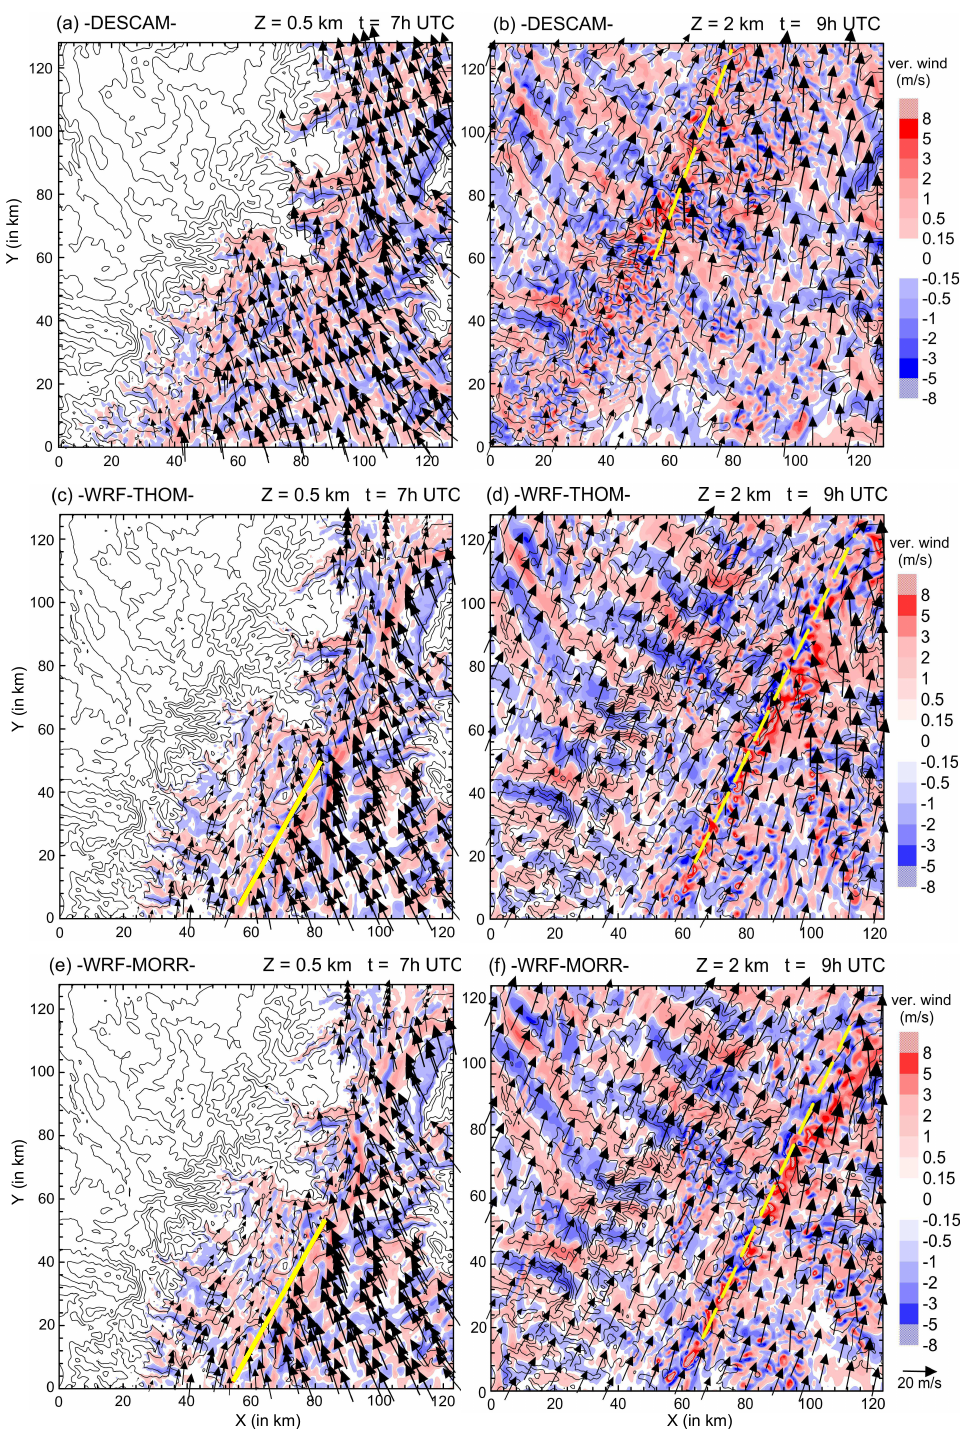
Figure 8. Horizontal and vertical wind components simulated over the innermost domain in DESCAM ( a , b ), WRF-THOM ( c , d ) and WRF-MORR ( e , f ) below the cloud system (at 0.5 km height) ( a , c , e ) and at the cloud base (at 2 km height) ( b , d , f ). The colour scale represents the vertical wind for which the updrafts and the downdrafts are given with, respectively, positive (red) and negative (blue) values. The horizontal wind is indicated by the arrows. The two time steps represent the wind field 1 h after the onset (i.e., 7:00 UTC) and at the end (i.e., 9:00 UTC) of the intense precipitation period. The yellow solid and dashed lines indicate respectively the position of the wind convergence in the WRF simulations (solid) and the position of the precipitation band (dashed) in the different simulations (see Figure